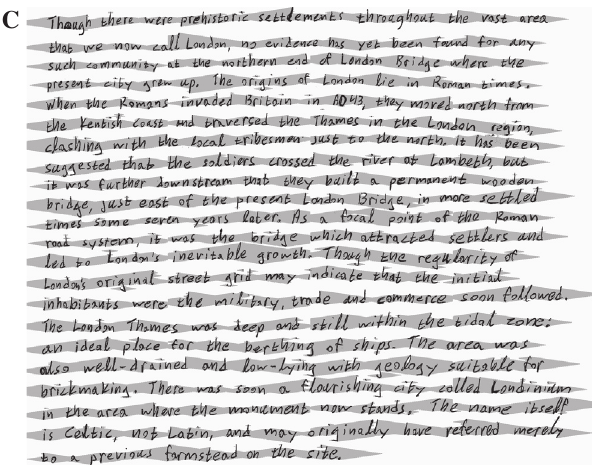
Figure 10. (A–C) Successfully Extracted Text Lines from Different Document